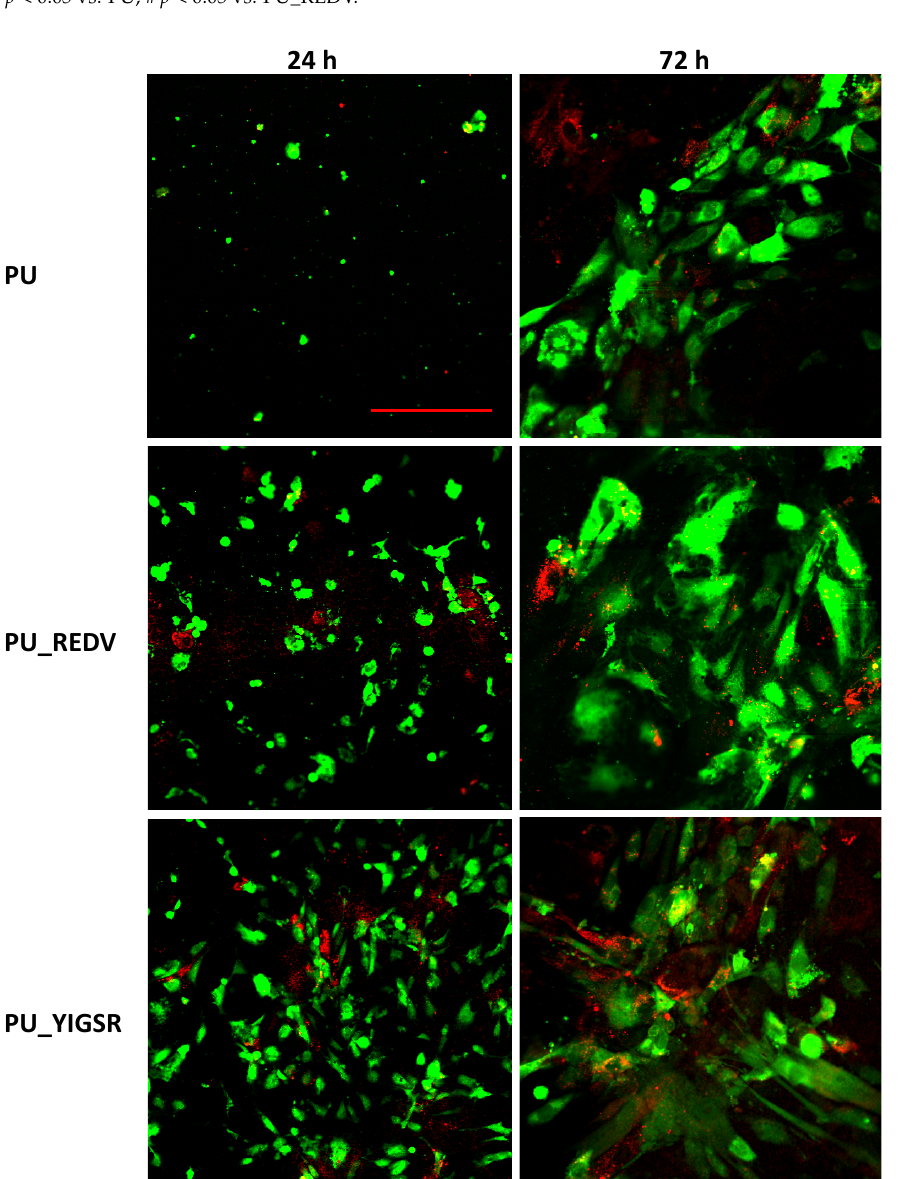
Figure 8. Endothelial cells (green) and smooth muscle cells (red) co-cultured on tested materials, scale bar 100 μm. Table 2. Percent of the area occupied by EC and SMC.